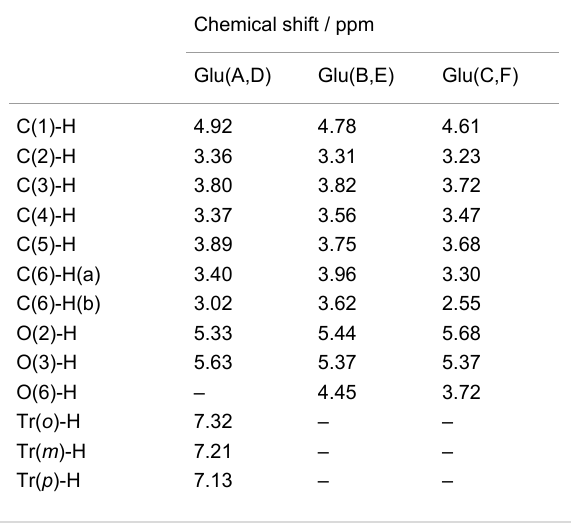
Table 1: Chemical shift of A,D- α -CD(tr) 2 in DMSO- d 6 at 50